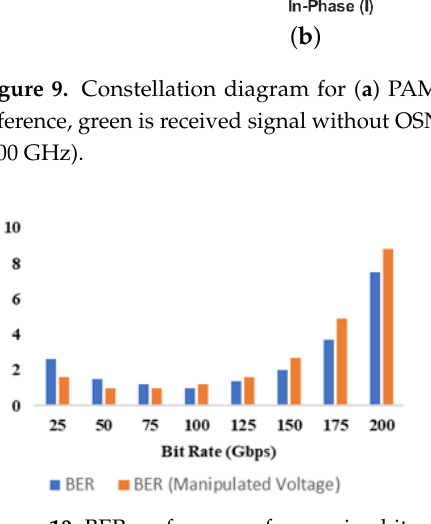
Figure 10. BER performance for varying bit rates with and without manipulated